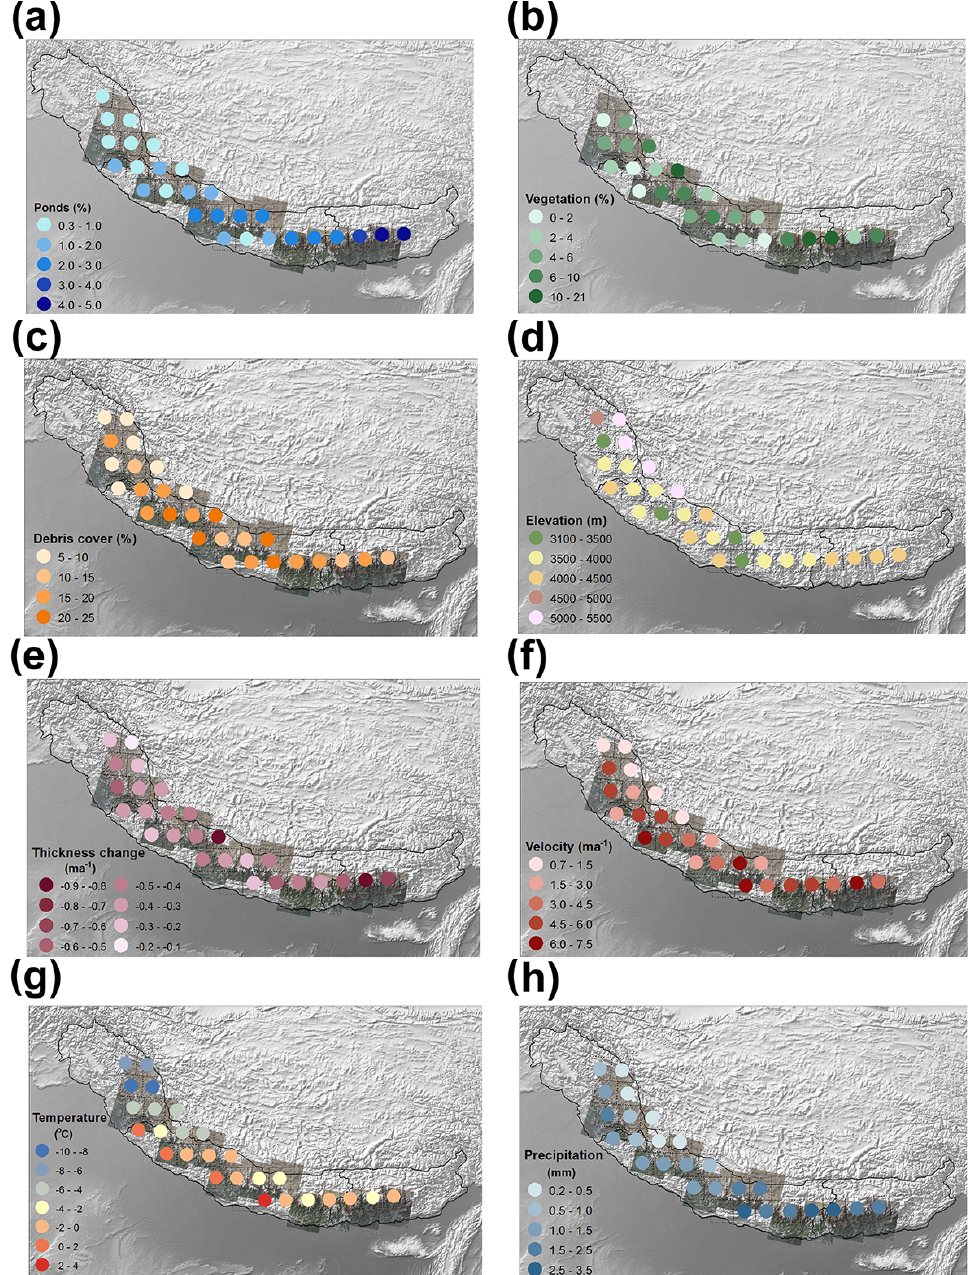
Figure 13. Plots of (a) LMM-derived ponds, (b) LMM-derived vegetation, (c) debris cover expressed as percent of the glacierized area, (d) minimum elevation of debris cover, (e) thickness change trends for 2000–2018 from Shean et al. (2020), (f) average velocity trends for 2013–2015 from Dehecq et al. (2015), (g) average temperature from ERA5-Land (October 2015) and (h) total precipitation from ERA5-Land (October 2015). All variables were averaged over the glacierized areas and gridded over 1 × 1 ◦ grid cells.